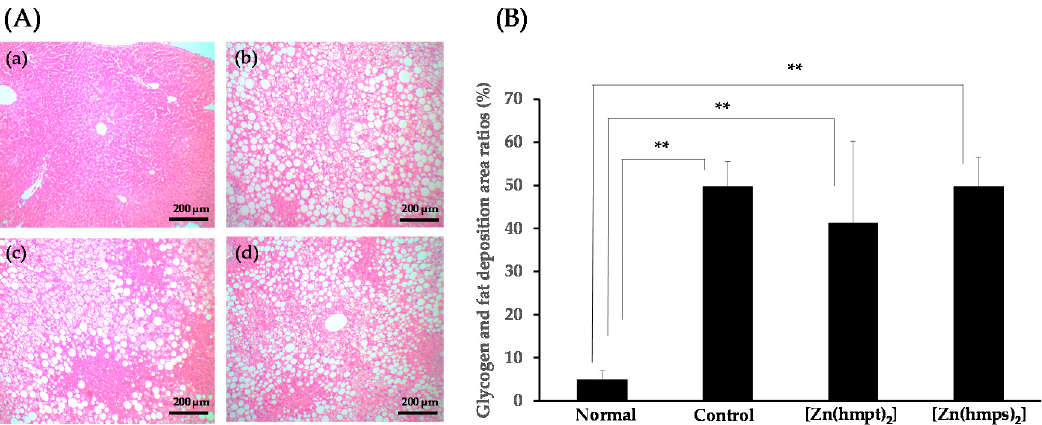
Figure 6. ( A ) Hepatic morphology in 14-week-old normal ( a ); control (PEG-400 administered) ( b ); [Zn(hmpt) 2 ]-treated ( c ); and [Zn(hmps) 2 ]-treated mice ( d ). Hematoxylin and eosin staining, ×100 (scale bar = 200 μ m); ( B ) Glycogen and fat deposition area ratios in the hepatic sectioned tissue of normal, control (PEG-400 administered), [Zn(hmpt) 2 ]-treated, and [Zn(hmps) 2 ]-treated mice. Data are expressed as the means ± SDs for 6–8 mice. Statistical analysis was performed using the Steel-Dwass test; significance: ** p < 0.01 vs. normal mice.